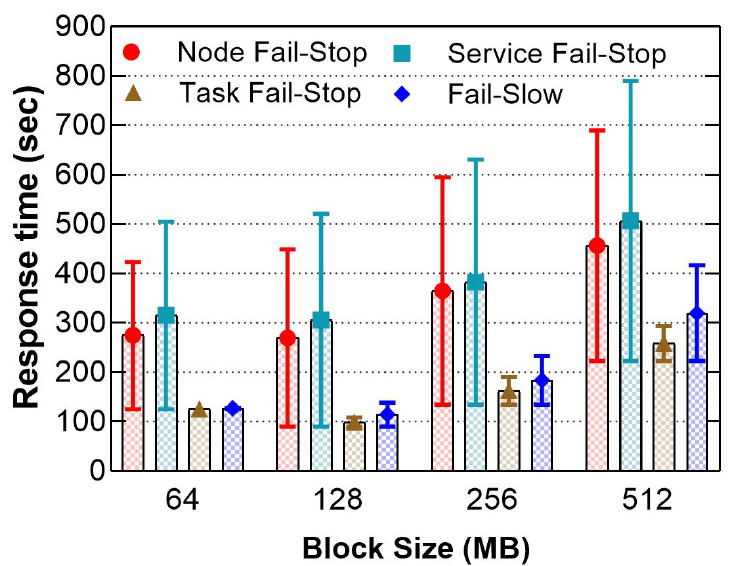
Figure 6. The response times’ difference when setting a different distribution of